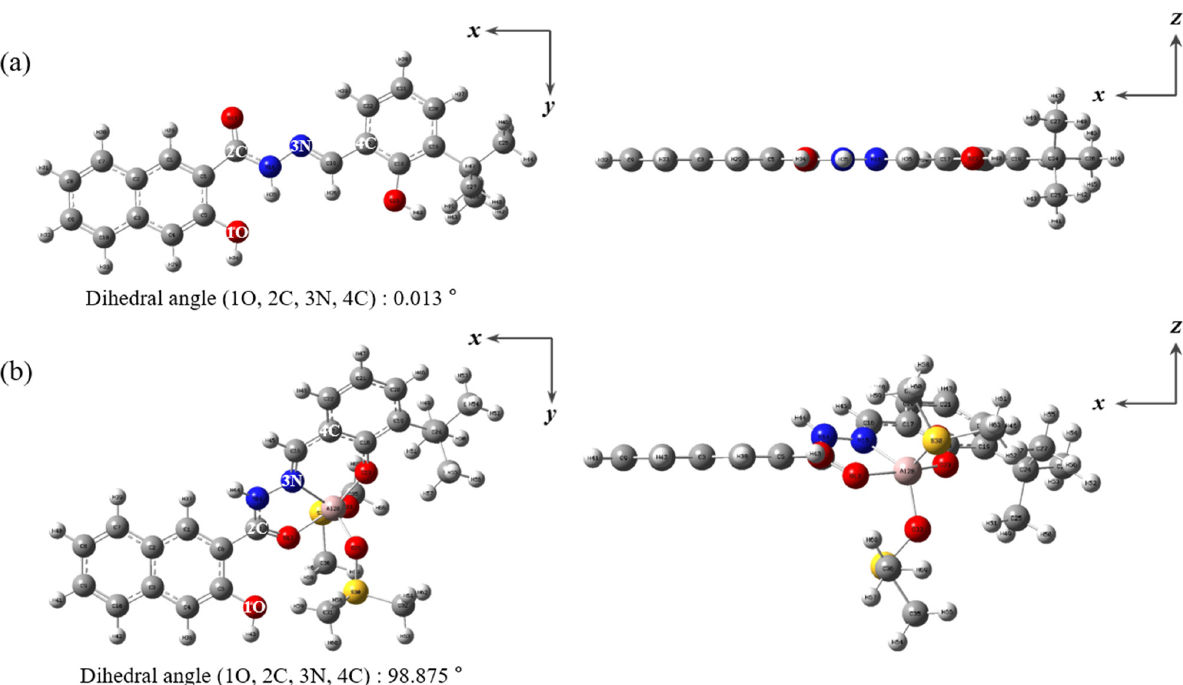
Figure 6. Energy-optimized forms of ( a ) NATB and ( b ) NATB -Al 3+ .